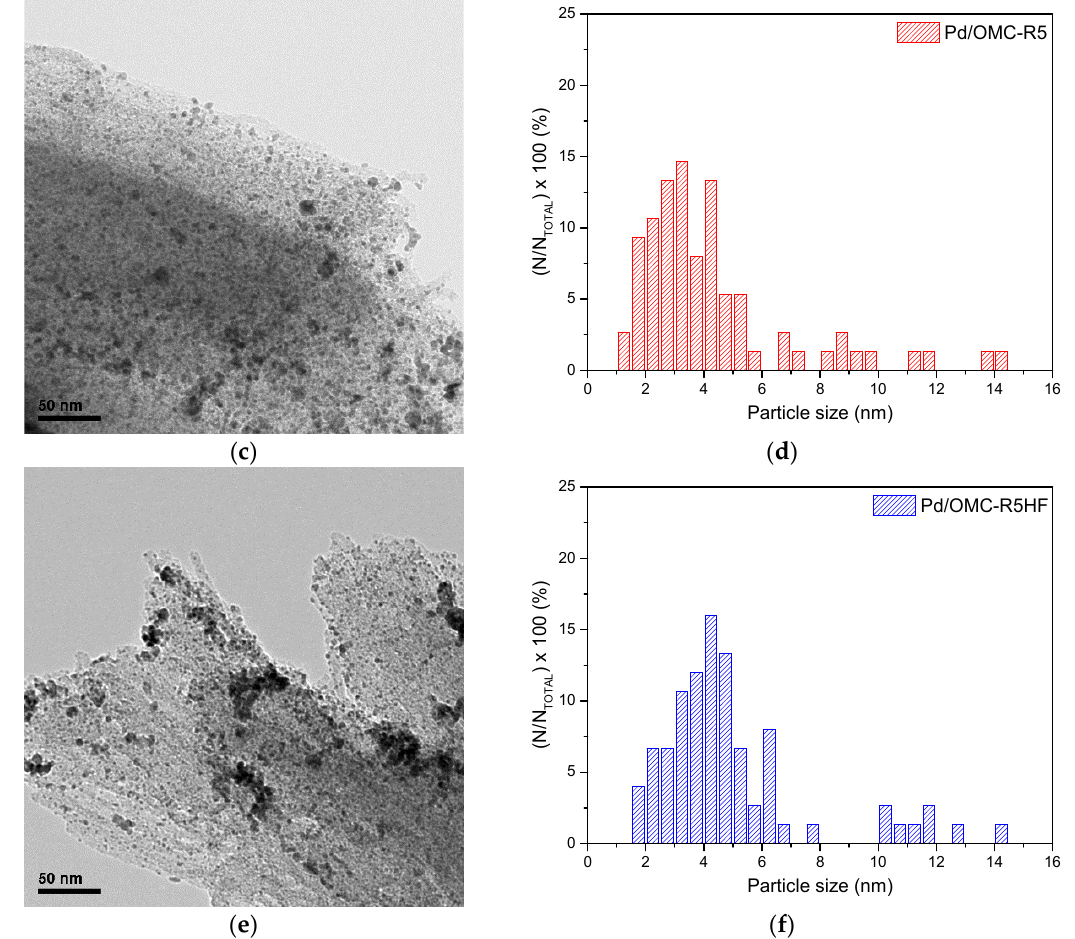
Figure 4. TEM images (left) and particle size distribution (right) of Pd / OMC catalysts: ( a , b ) Pd / OMC-R2; ( c , d ) Pd / OMC-R5; ( e , f ) Pd / OMC-R5HF.